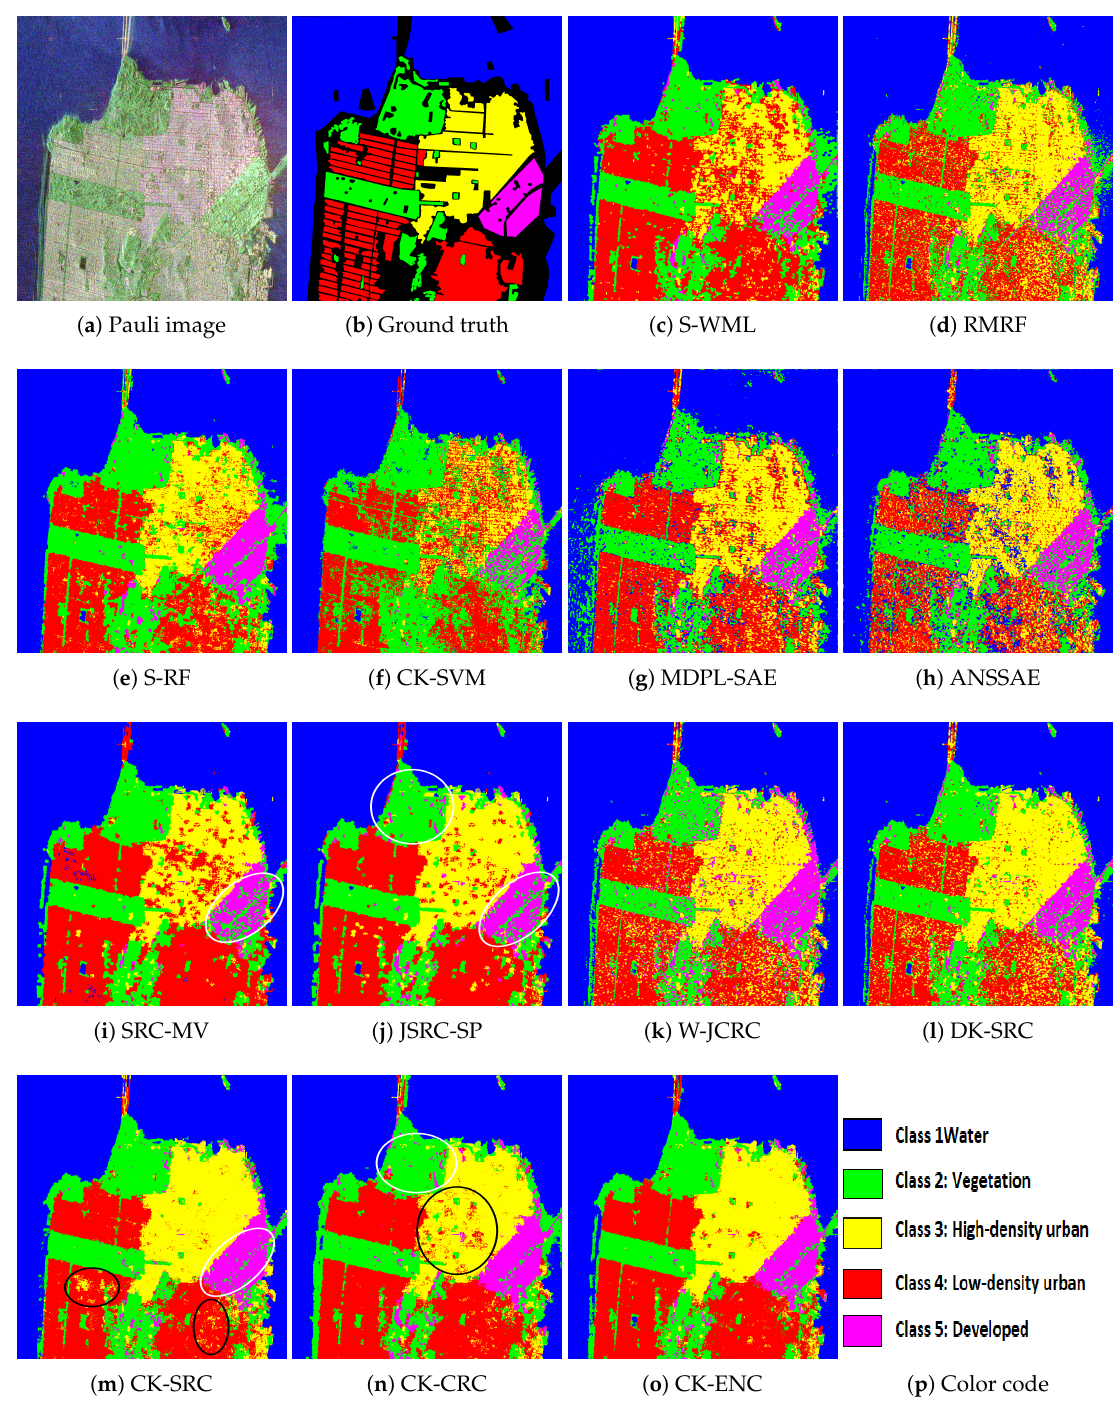
Figure 10. Classification results of the San Franciso dataset with different